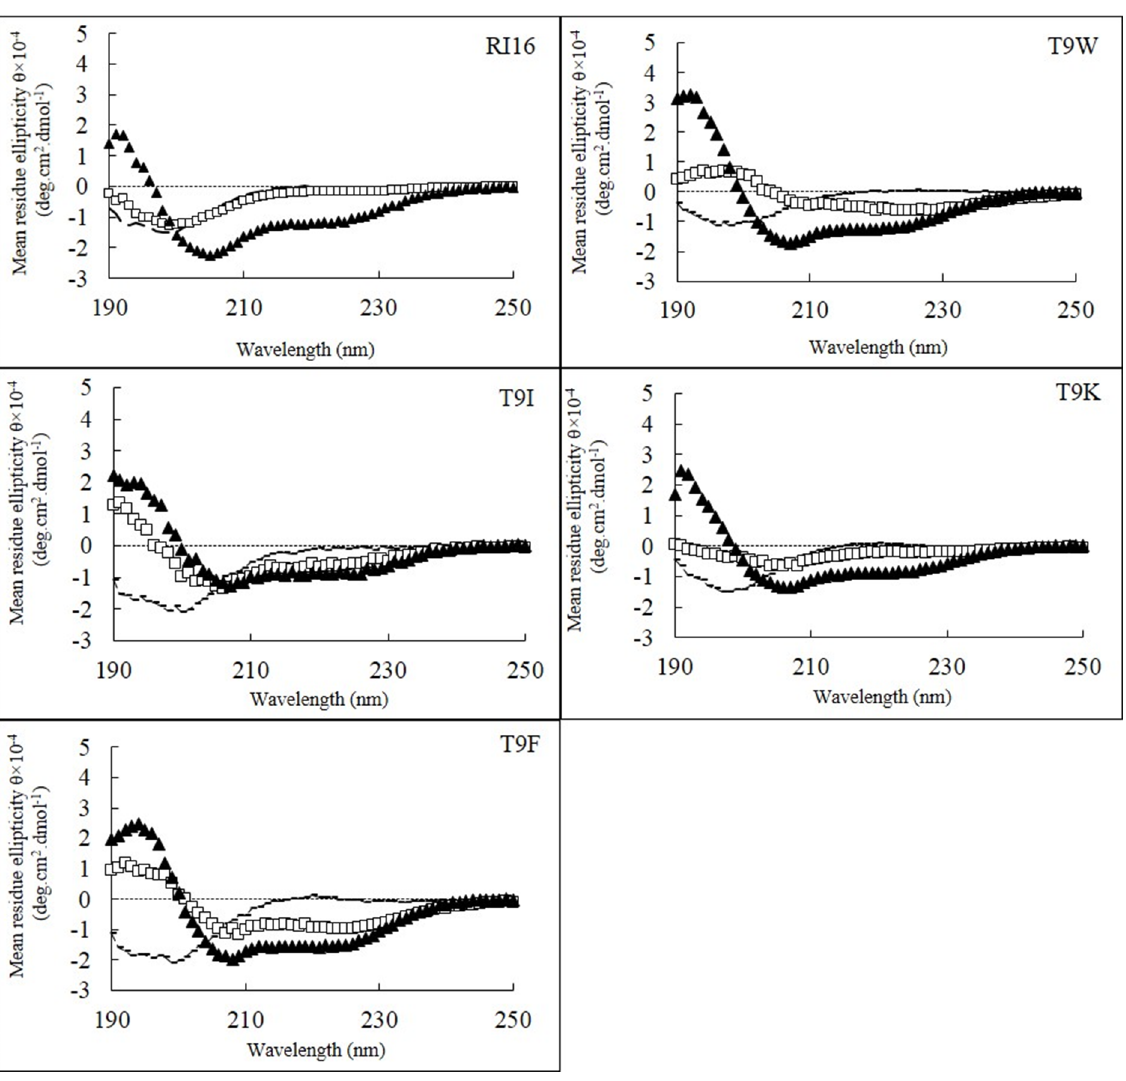
Fig. 2. The CD spectra of the peptides. The peptides were dissolved in 10 mM PBS (pH 7.4) (dashed lines), 50% TFE (triangles), or 30 mM SDS (squares). The mean residue ellipticity was plotted against wavelength. The values from three scans were averaged per sample, and the peptide concentrations were fixed at 150 m